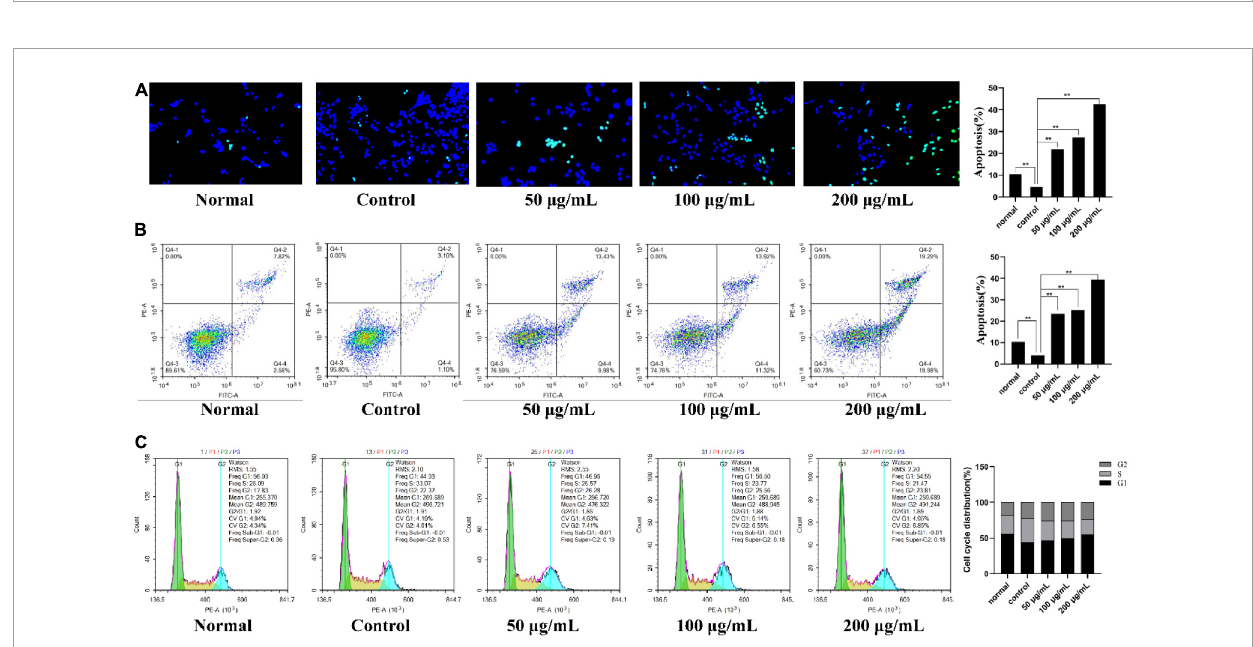
FIGURE7 Mechanism investigation of PKP2-1 in anti-inflammatory activity based on MH7A cells. (A) Apoptosis-inducing effect of PKP2-1 on MH7A cells; (B) Apoptotic assay by flow cytometry assay; (C) The effect of PKP2-1 on the cell cycle of MH7A cells; MH7A cells were treated with TNF- α (20 ng/mL) and PKP2-1 (50, 100, and 200 µ g/mL) for 24 h, and apoptotic cells were detected by Annexin V-FITC\/PI staining, followed by flow cytometry Cytological analysis, Data were represented as Mean ± SD ( n = 3), ** p < 0.01, vs. Control cells (MH7A cells treated by TNF- α